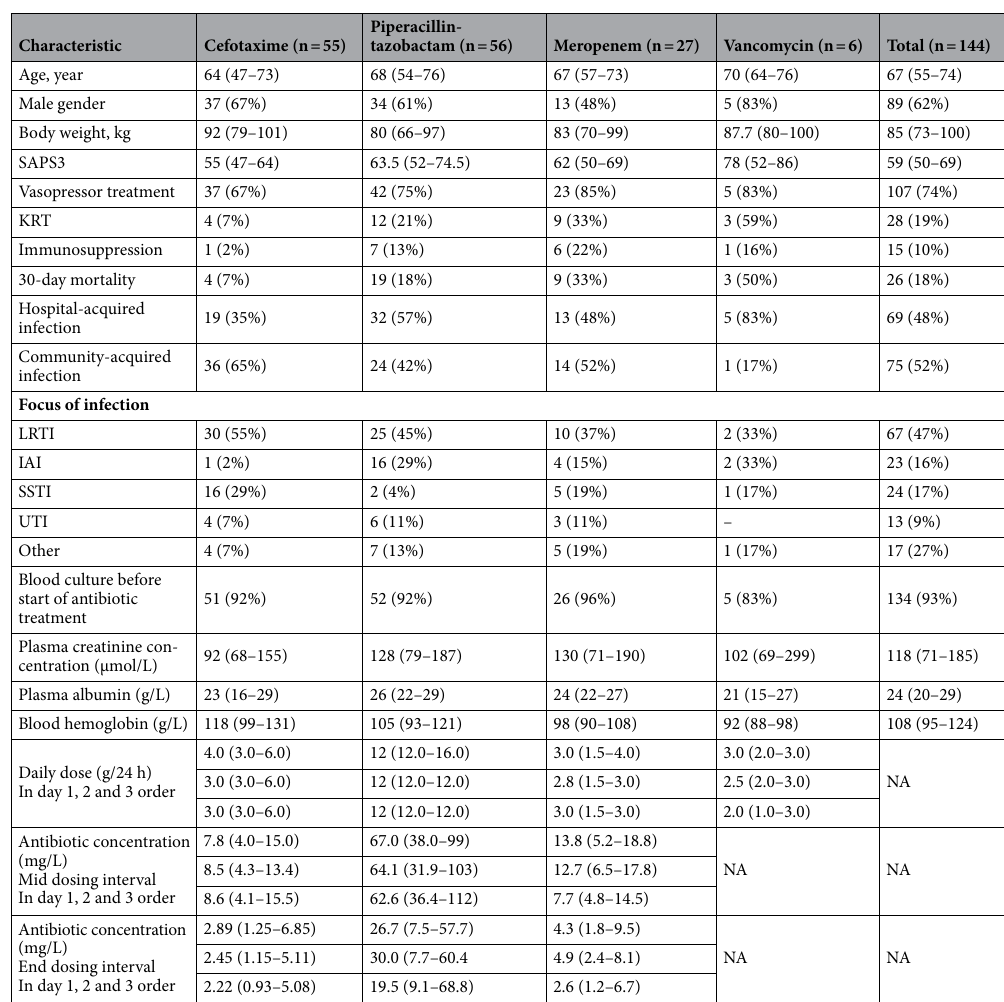
Table 1. Demographic and clinical characteristics of the included patients. Data are presented as median (IQR) or number (percentages). KRT kidney replacement therapy. Immunosuppression: Neutropenic fever, stem cell-/solid organ transplantation OR prednisolone treatment of more than 20 mg per day due to inflammatory rheumatic disease or haematological diseases at admission. Hospital-acquired infection: Symptoms developed more than 48 h after admission to hospital. Community-acquired infection: Symptoms developed before hospitalisation or within 48 h after admission. Focus of infection: LRTI lower respiratory tract infection, IAI intra-abdominal infection, SSTI soft skin and tissue infection, UTI urinary tract